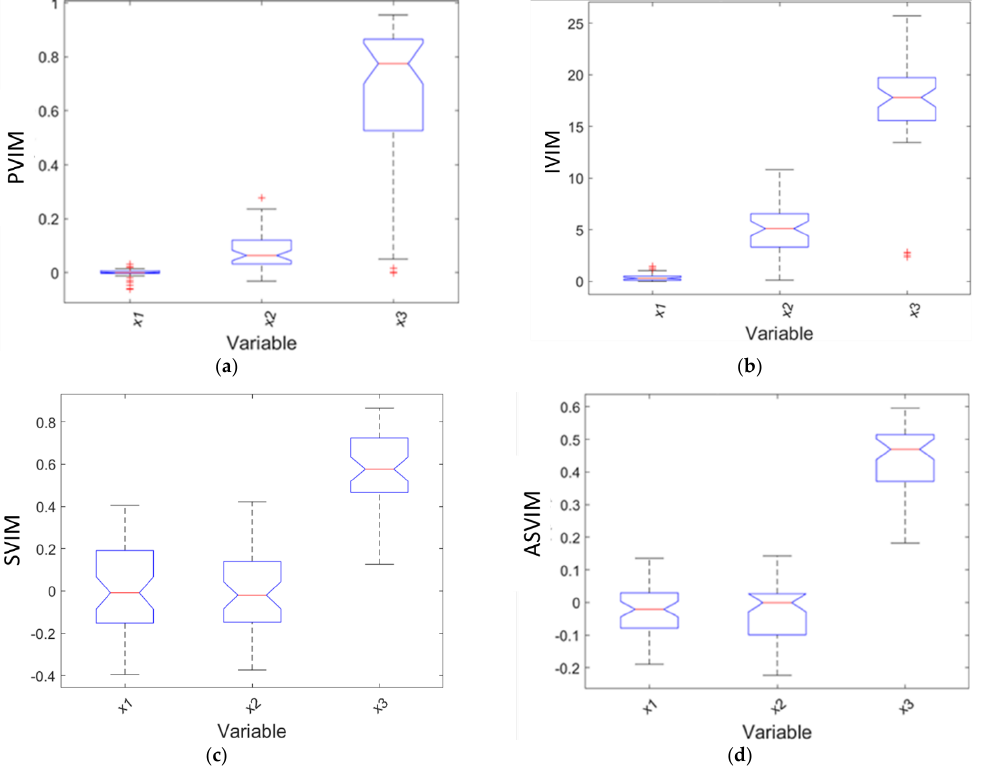
Figure 2. Relative importance of the uncorrelated predictors in Case Study 1 based on 50 runs, show- ing ( a ) permutation indices, MSE on OOB data, ( b ) impurity indices on OOB data, ( c ) Shapley val- ues, R 2 on test data, and ( d ) approximate Shapley values (R 2 ) on test data.